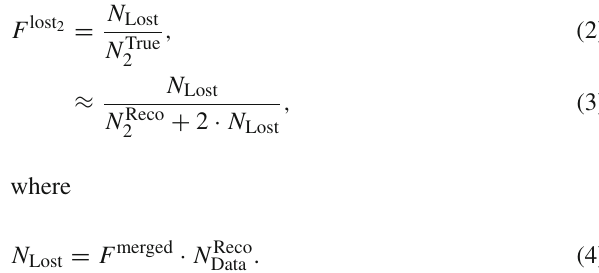
is 0.3–0.5% in the simulation. The multiple-track template, displayed as squares in the same figure, instead exhibits a peak in the d E / dx range expected for two MIPs. A third, smaller peak occurs at d E / dx > 3.2 MeVg − 1 cm 2 for clus- ters created by three particles. The peak in the multiple-track template d E / dx distribution at values expected for one MIP is due to the fact that multiply used clusters can also originate from shared clusters or clusters identified as merged which, in truth, are not merged